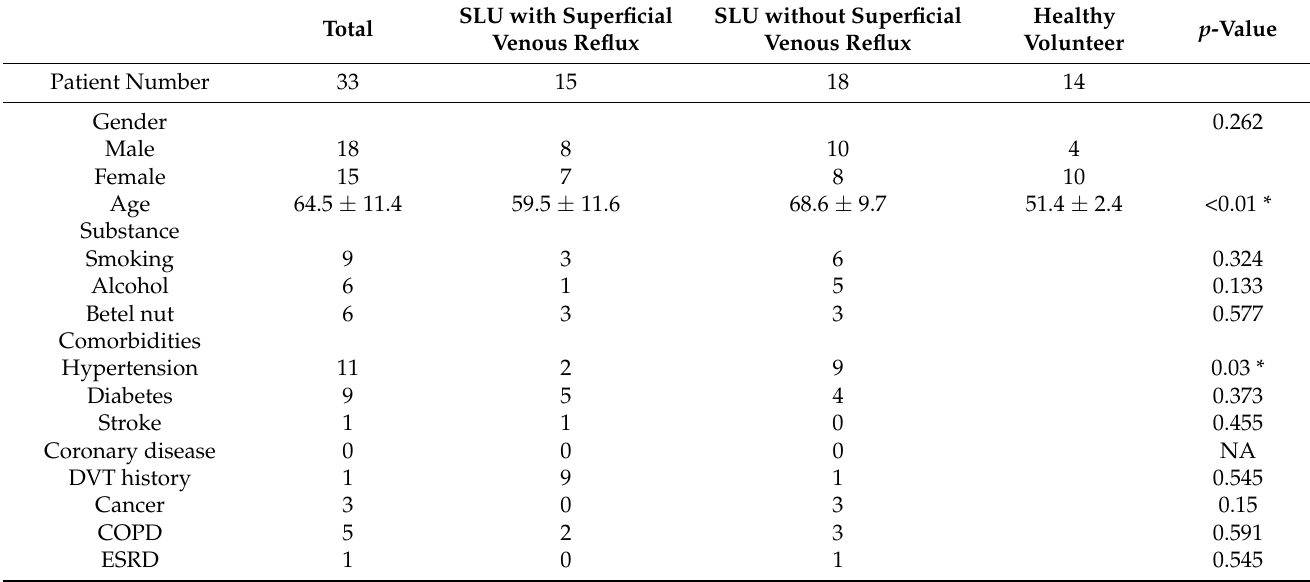
Table 1. Demographic characteristics of the 33 patients with